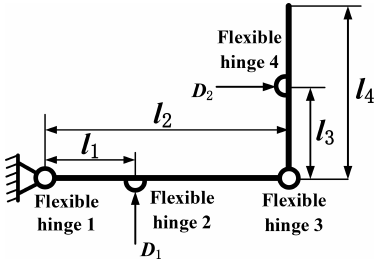
Figure 6. Geometric model of the compliant lever mechanism.